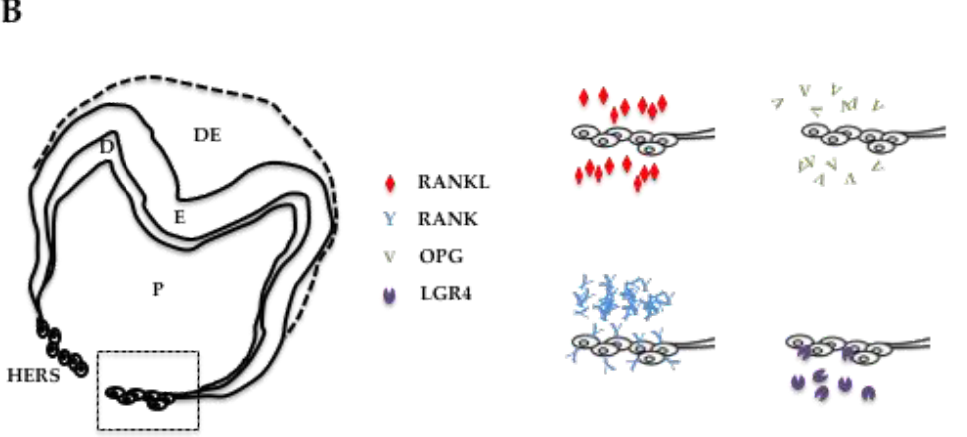
Figure 3. RANKL, RANK, OPG and LGR4 expression patterns in the mandible first molar of 5-day-old wild-type mice. ( A ) Immunohistochemistry experiments were carried out on 5- µ m-thick frontal sections of 5-day-old wild-type C57BL / 6 mouse heads for RANKL, RANK, OPG and LGR4. RANKL and OPG expressions were observed in some mesenchymal cells in the pulp, mainly facing Hertwig’s epithelial root sheath, in mesenchymal cells in the apical papilla, and in certain alveolar bone cells (arrowheads). RANK expression was high in the pulp, in Hertwig’s epithelial root sheath and in the cells at the bone surface. Mild LGR4 expression was evidenced in some cells in Hertwig’s epithelial root sheath and the apical papilla (arrowheads), and in most cells at the alveolar bone surface. Scale: 20X / 100 µ m. ( B ) Schematic representations of established RANKL, RANK, OPG and LGR4 expression patterns in 5-day-old wild-type C57BL / 6 mice mandibular first molar roots. The cells in Hertwig’s epithelial root sheath expressed only RANK and LGR4, with a significant di ff erence in the number of stained cells and the staining intensity in favor of RANK. DE: dental epithelium; E: enamel; D: dentin; P: pulp; HERS: Hertwig’s epithelial root sheath.